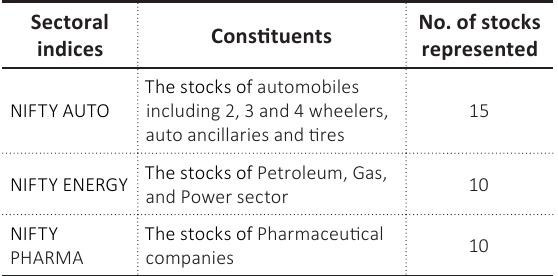
Table 2. Nifty sectoral indices and their description